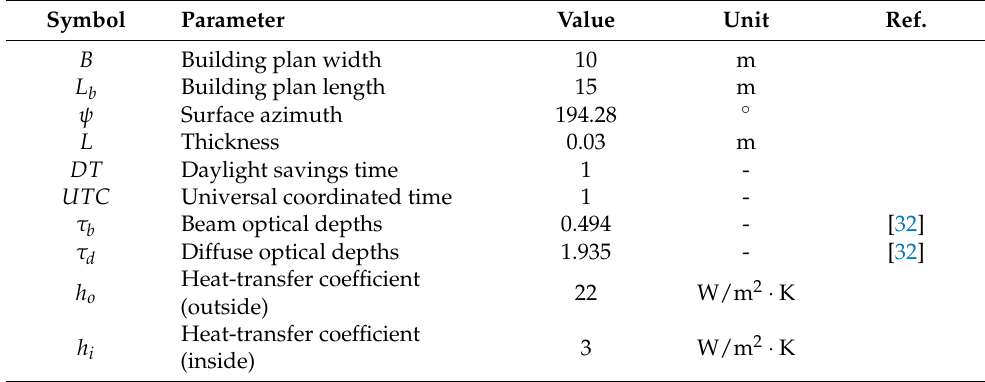
Table 2. Properties of Pescara’s Justice Court used in this